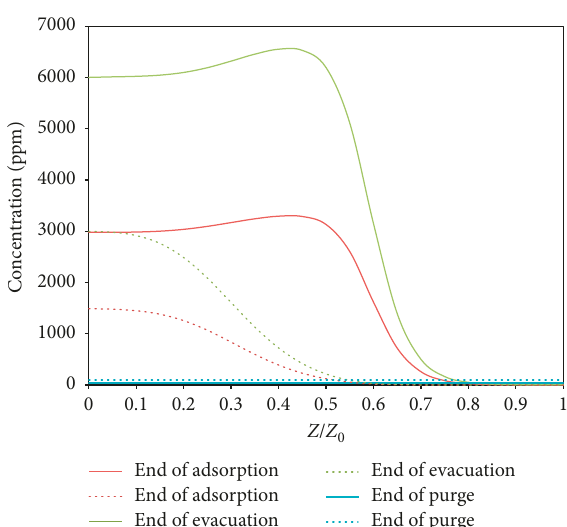
Figure 10: Simulated axial concentration profiles of dichloro- methane and acetone at the end of different steps of the cycle at steady state. Solid lines: dichloromethane and dotted lines: